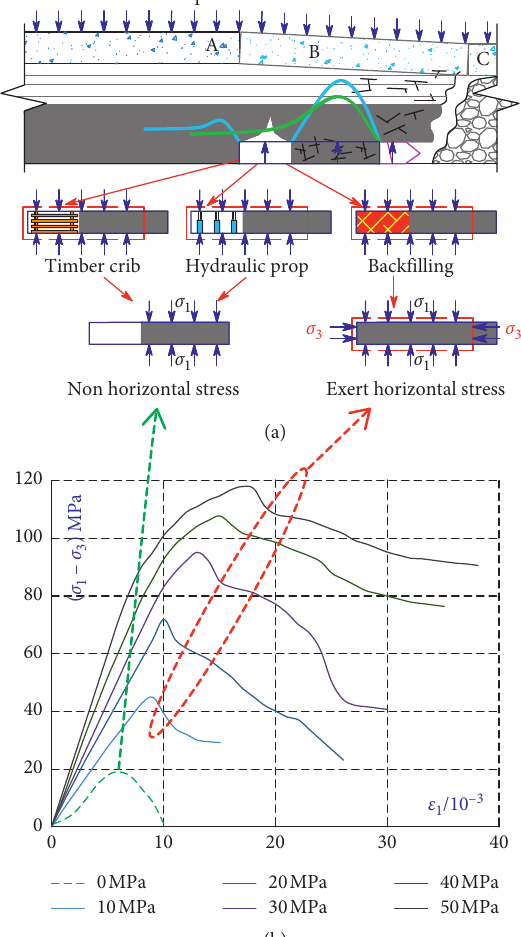
Figure 12: The analysis of the backfilling mechanism of the abandoned roadway. (a) Mechanical model; (b) stress-strain